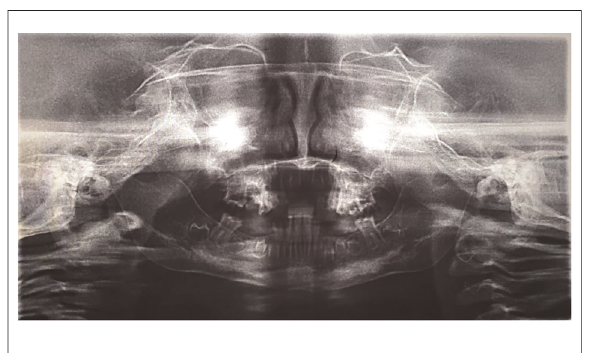
FIGURE 3 Panoramic radiograph showing the absence of mandibular condyles and ghost teeth